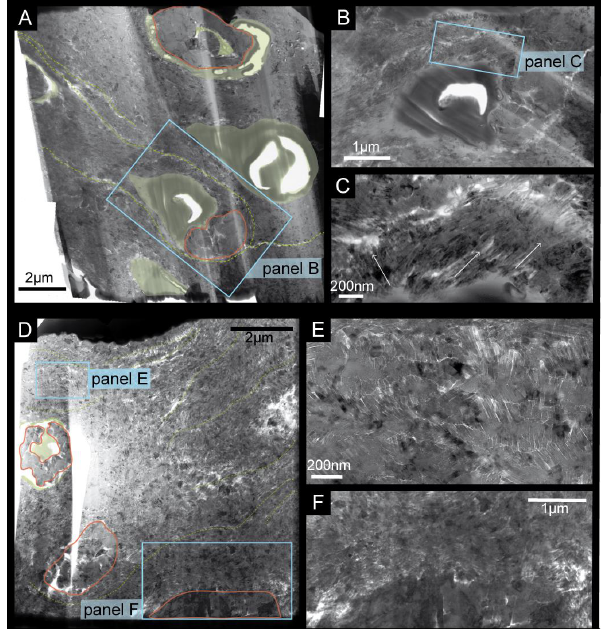
Figure 4. TEM pictures of FIB foils A and B. (A,D) Picture of the whole FIB foils A and B, respectively. Organic matter appears smooth (green) while other areas are filled with fibrous aragonite (aragonite type 1) except for areas surrounded by orange lines where crystals of aragonite are bigger (aragonite type 2). Lines of less resistance in the type 1 aragonite pattern are highlighted by green dotted lines. They delineate the limits between cells. (B) Close-up of the area outlined in (A) showing an encrusted cell. (C) Close-up of the area outlined in (B) showing the radial distribution of aragonite needles at the surface of the cell. (E) Close-up of the area outlined in (D) showing the textural organization of successive aragonite type 1 layers. (F) Close-up of the area outlined in (D) showing the limit between type 1 aragonite and type 2 aragonite; no organic matter remains associated with the inner part of the cell at this stage of